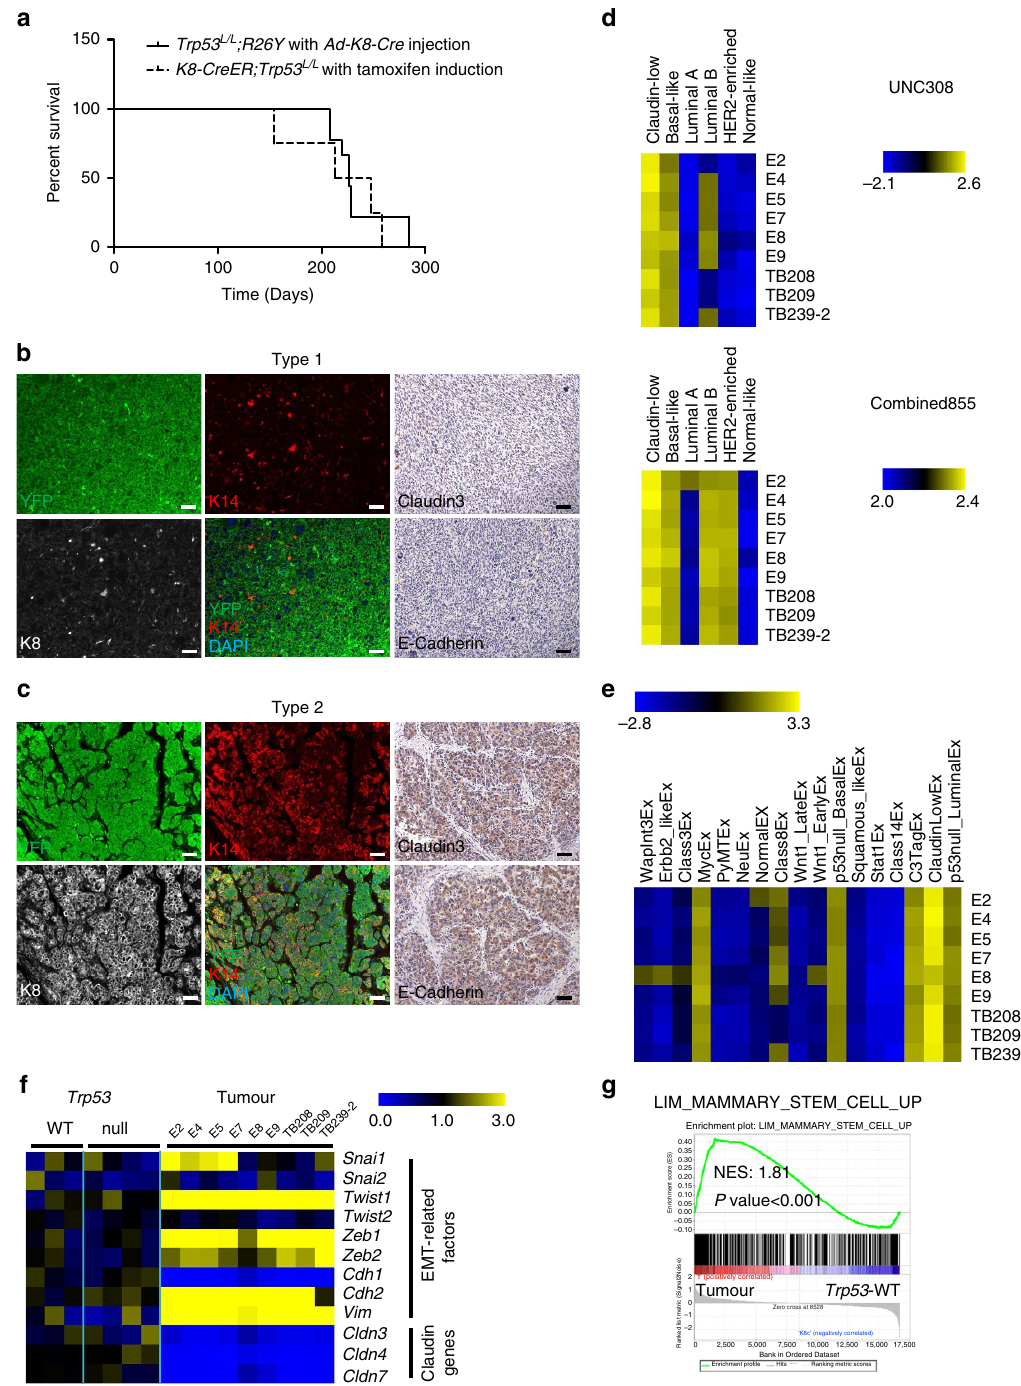
Figure 4 | Induced loss of p53 in luminal cells leads to development of mammary tumours with loss of luminal identity. ( a ) Kaplan–Meier survival curves showing all Trp53 L/L females ( n ¼ 9) injected with Ad-K8-Cre or K8-CreER;Trp53 L/L females ( n ¼ 4) induced by tamoxifen (2mg per mouse, one injection) developed mammary tumours with a similar latency. ( b , c ) Co-IF staining (for YFP, K8, K14, left and middle panels) and immunohistochemical (IHC) staining (for Claudin 3 and E-Cadherin, right panels) showing that most mammary tumours developed in cohorts in a were YFP þ mammary tumours that were largely negative for K8 and K14, and were negative for Claudin 3 and E-Cadherin ( b , Type 1). In addition, a small number of mammary tumours developed in cohorts in a were YFP þ ;K8 þ ;K14 þ ;Claudin 3 þ ;E-Cadherin þ mammary tumours ( c , Type 2). Scale bars, 50 m m. ( d , e ) Heatmaps summarizing GSEA results (plotted as NES, from Supplementary Data 1), based on comparisons of microarray data of each tumour to those of Trp53 -WT luminal MECs and to gene sets representing human ( d ) and murine ( e ) intrinsic subtypes. The gene sets were extracted from Pfefferle et al. (Human intrinsic subtypes were based on the UNC308 data set and Combined855 data set) 37 . ( f ) Heatmap showing upregulation of EMT-related genes and downregulation of E-Cadherin gene ( Cdh1 ) and Claudin genes in Type 1 (and to a lessor gene, in Type 2 (E8)) tumours. For each gene, the expression value from each sample was normalized to the mean of WTsamples ( ¼ 1) and the resulting relative expression value (that is, fold change to the mean of WT) was shown on the heatmap. ( g ) GSEA plot showing significant enrichment of a MaSC-related gene set based on Lim et al 36 in all tumours in relation to Trp53 -WT luminal MECs (that is, cellular origin). NES and nominal P value are